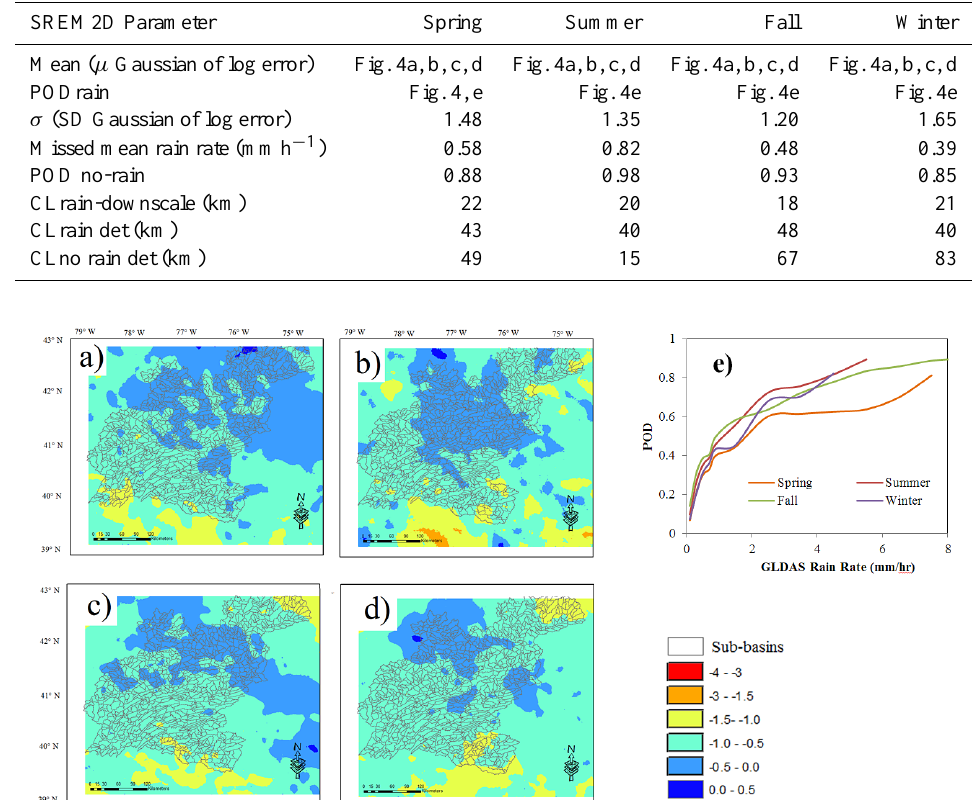
Figure 4. SREM2D parameters, 2-D spatial mean of logarithmic error “e” for each season: (a) spring, (b) summer, (c) fall, and (d) winter. (e) Probability of rain detection as a function of GLDAS rain